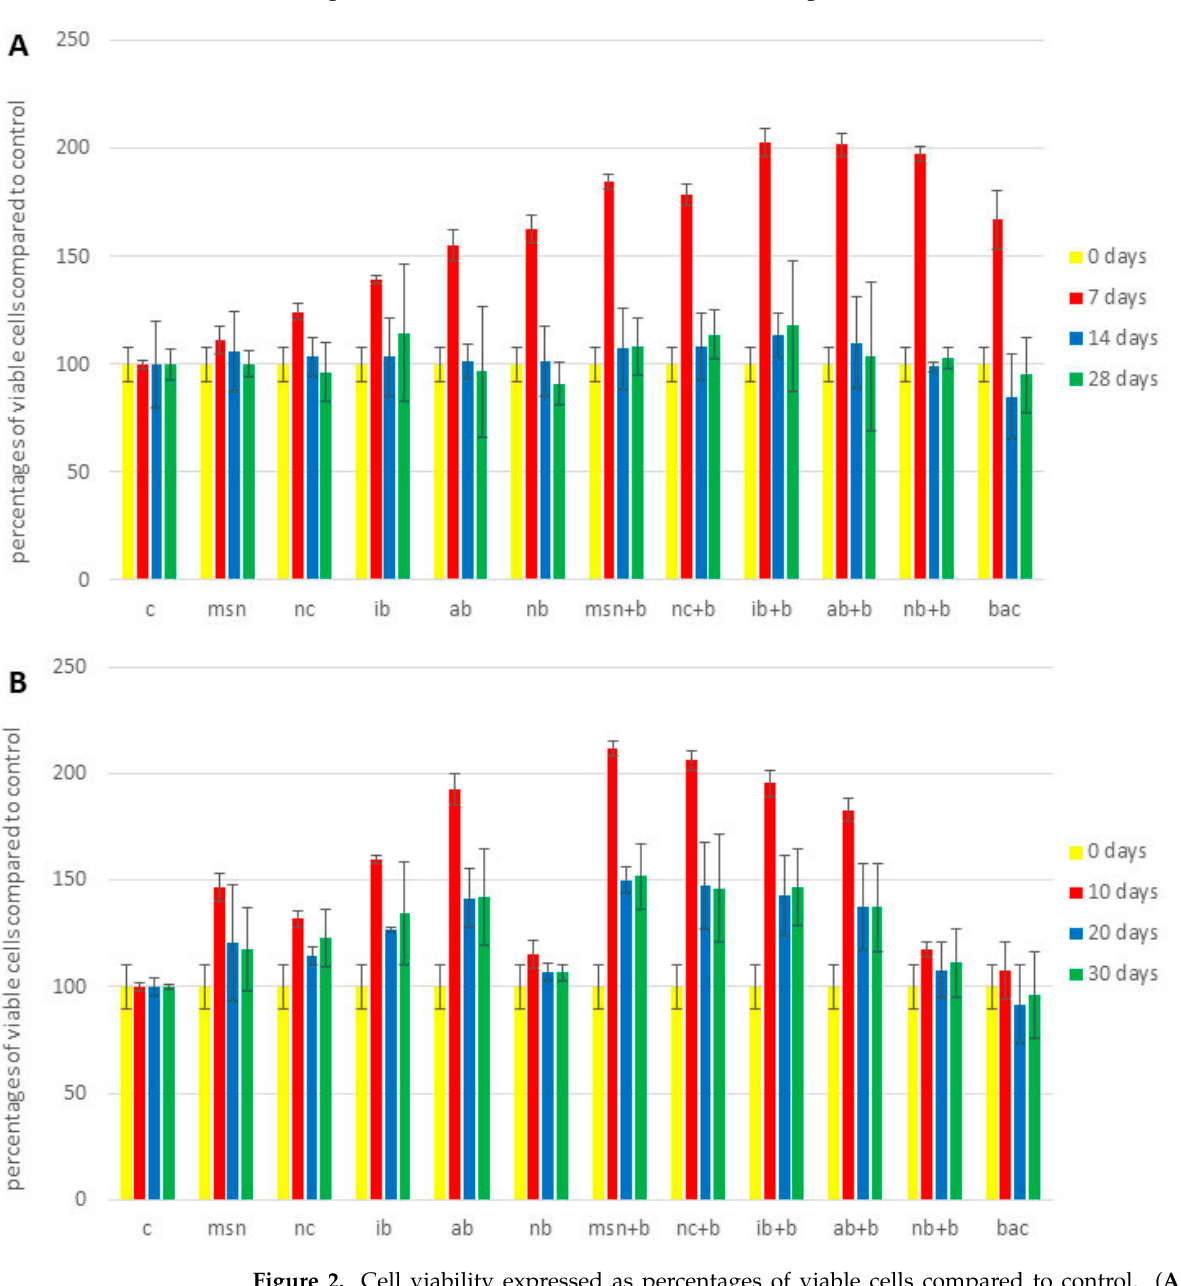
Figure 2. Cell viability expressed as percentages of viable cells compared to control. ( A ) 2nd tomato experiment; ( B ) watermelon experiment. Abbreviations: C—control; MSN—chitosan-coated meso-